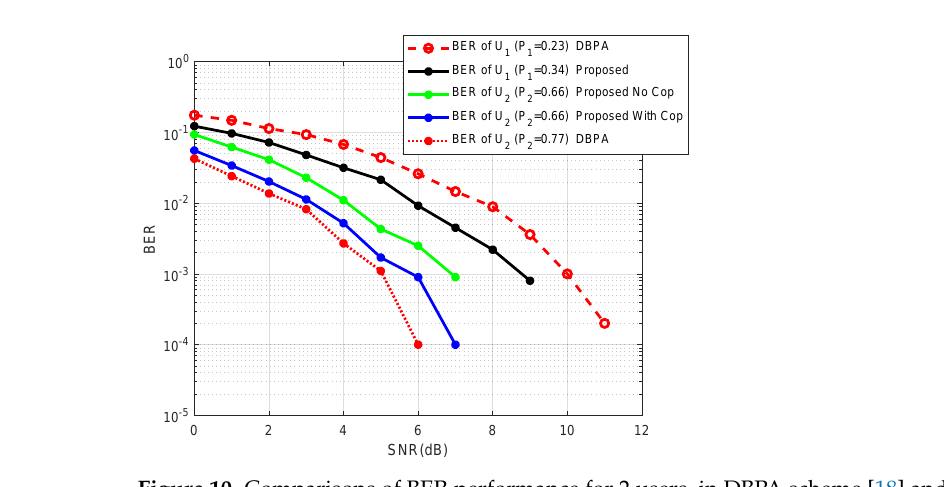
Figure 10. Comparisons of BER performance for 2 users, in DBPA scheme [18] and the proposed FIS based model.